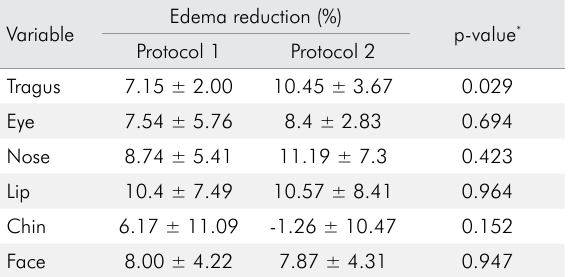
Table 4. Comparison of edema reduction in percentage and between the two groups: ERAS group (Protocol 1) and control group (Protocol 2).